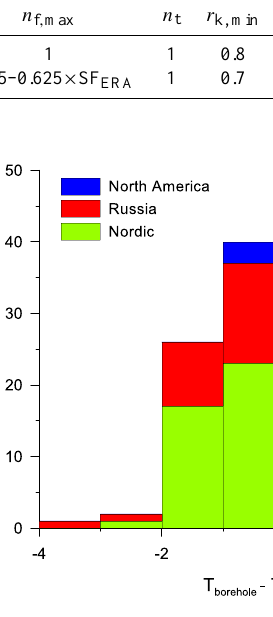
Figure 3. Histogram of the difference between modeled and mea- sured ground temperatures for 143 borehole sites (International Per- mafrost Association,